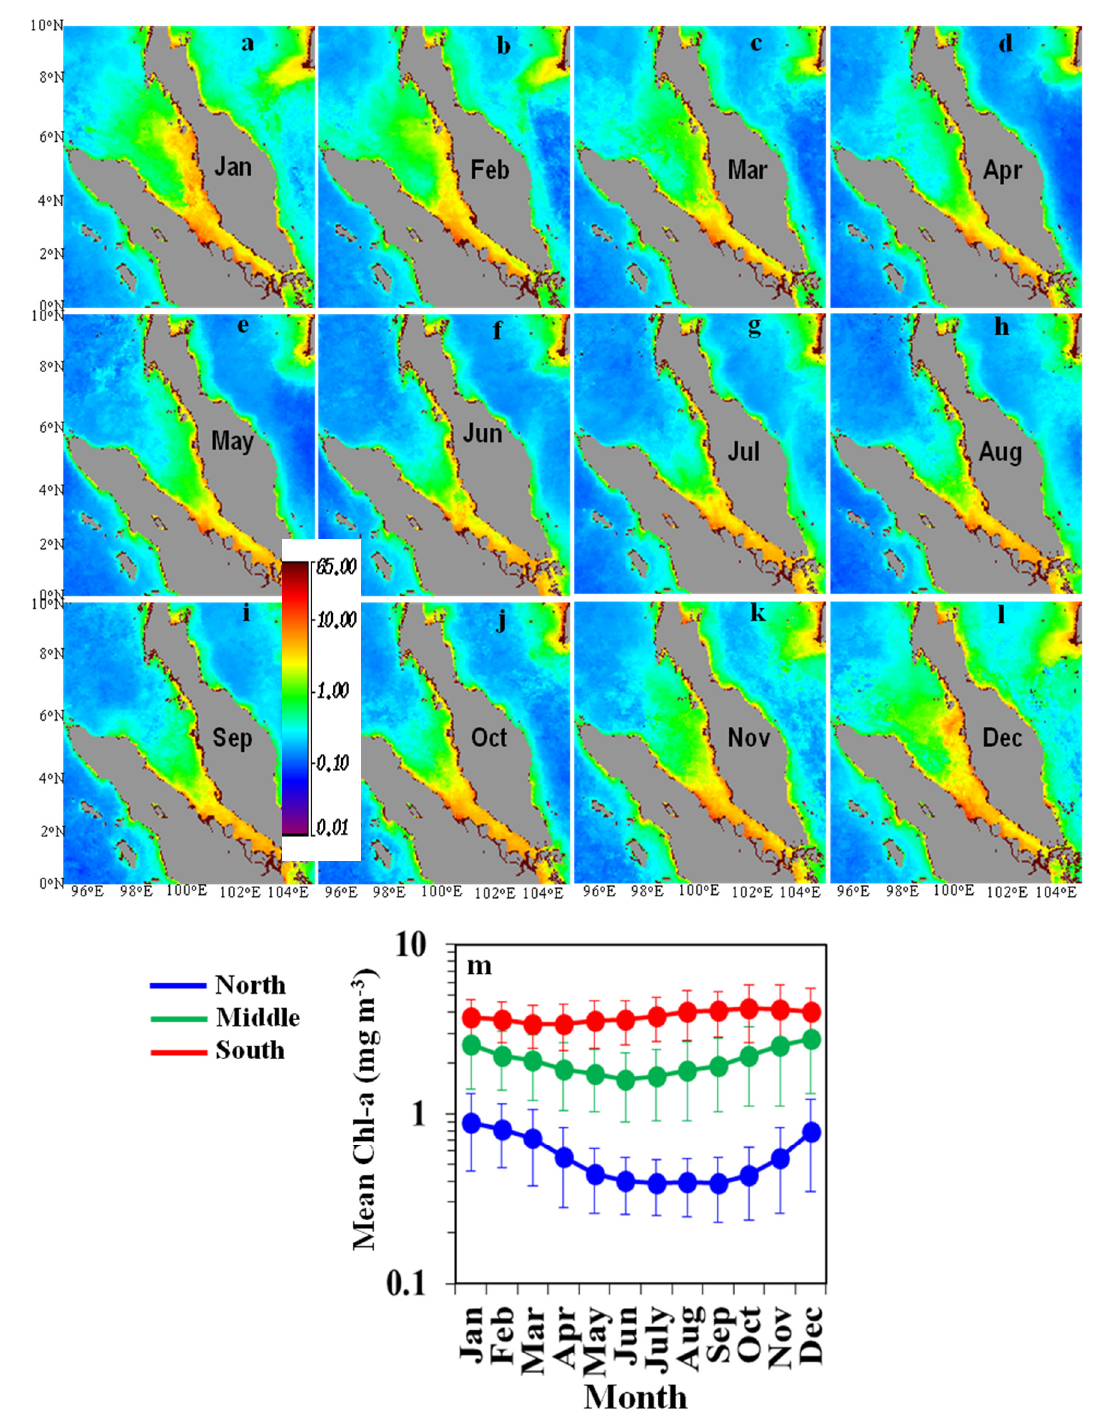
Figure 2. ( a – l ) Monthly climatological means of chlorophyll- a concentration (Chl- a , mg∙m −3 ) averaged from monthly SeaWiFS Chl- a (September 1997, to December 2010); ( m ) spatial means of monthly climatological SeaWiFS Chl- a in the northern, middle and southern regions of the SM. Vertical bars in (m) indicate standard deviations around the SeaWiFS Chl- a